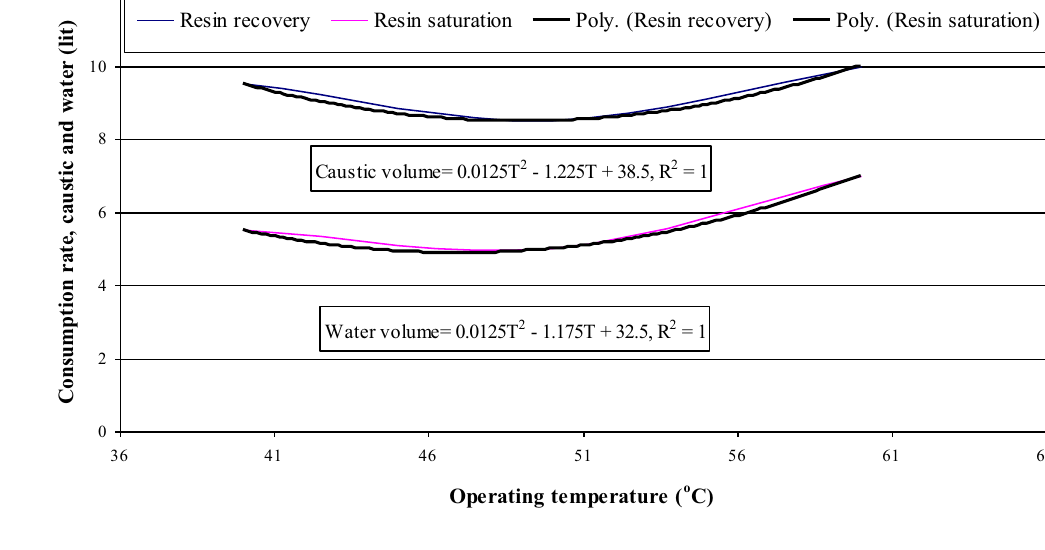
Fig. 2 Effect of temperature on the amount of used caustic for resin recovery